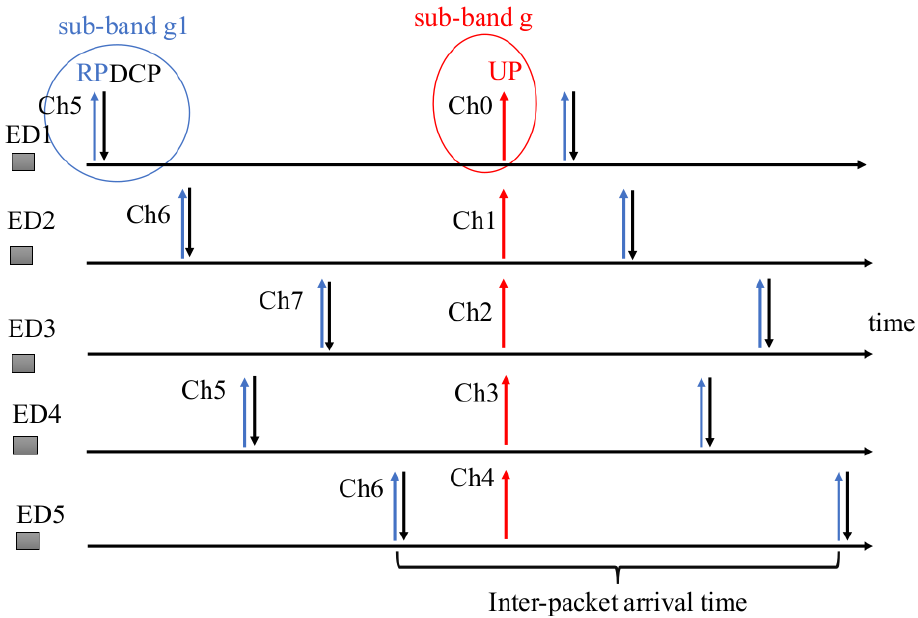
Figure 9. A schematic diagram of transmission of RP, UPs and DCP for 5 EDs belonging to the same cluster where each ED transmits UPs at the same time using different channels from sub-band